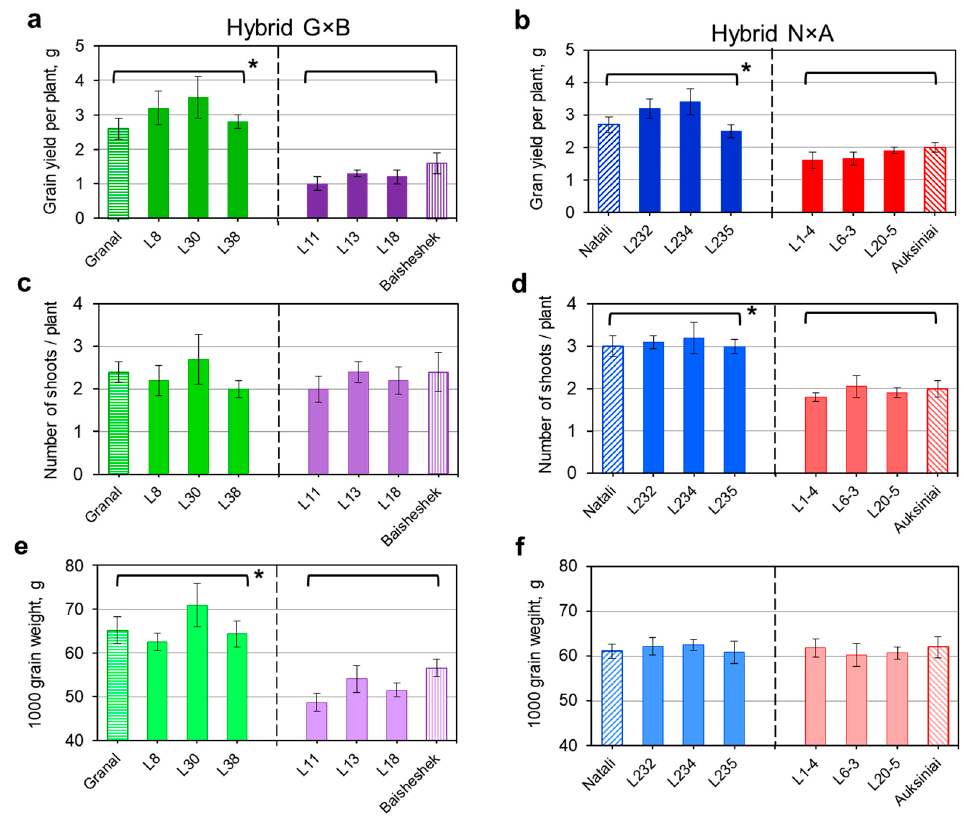
Figure 5. Grain yield and components in barley plants from two hybrid populations, Granal × Baisheshek (G × B) ( a , c , e ), and Natali × Auksiniai-2 (N × A) ( b , d , f ), grown in pots with soil under moderate drought until harvest. Eight genotypes including both parents and six breeding lines for the hybrid population identified in this study are separated by a dashed line in the figure panels. Grain yield per plant ( a , b ), number of shoots per plant ( c , d ), and 1000 grain weight ( e , f ), are presented as mean bars ± SE for 15 harvested plants (5 plants × 3 pots) for each genotype. Significant differences ( p < 0.05) are indicated by asterisks (*) between average values for corresponding groups of genotypes, calculated using ANOVA